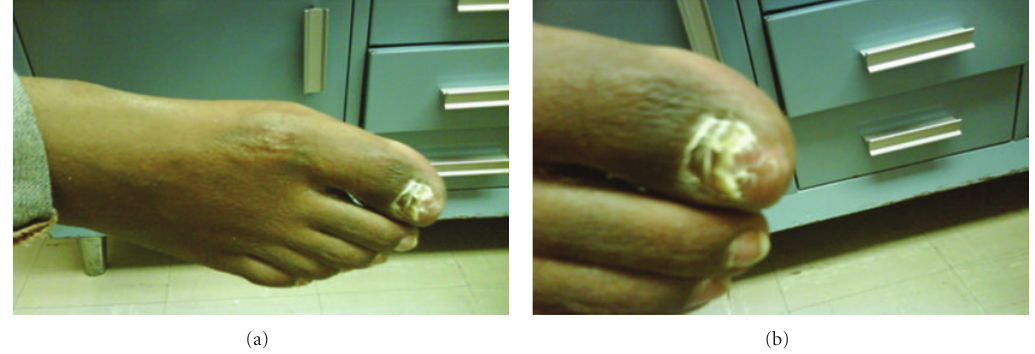
Figure 2: Resolution of all lesions after 6cycles of CHOP